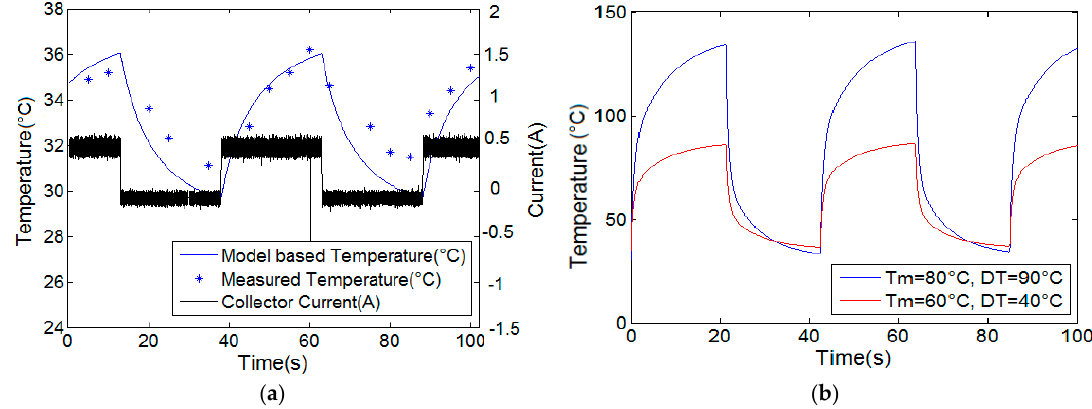
Figure 19. ( a ) Temperature monitoring by thermal camera ( b ) Accelerated power cycling test data.